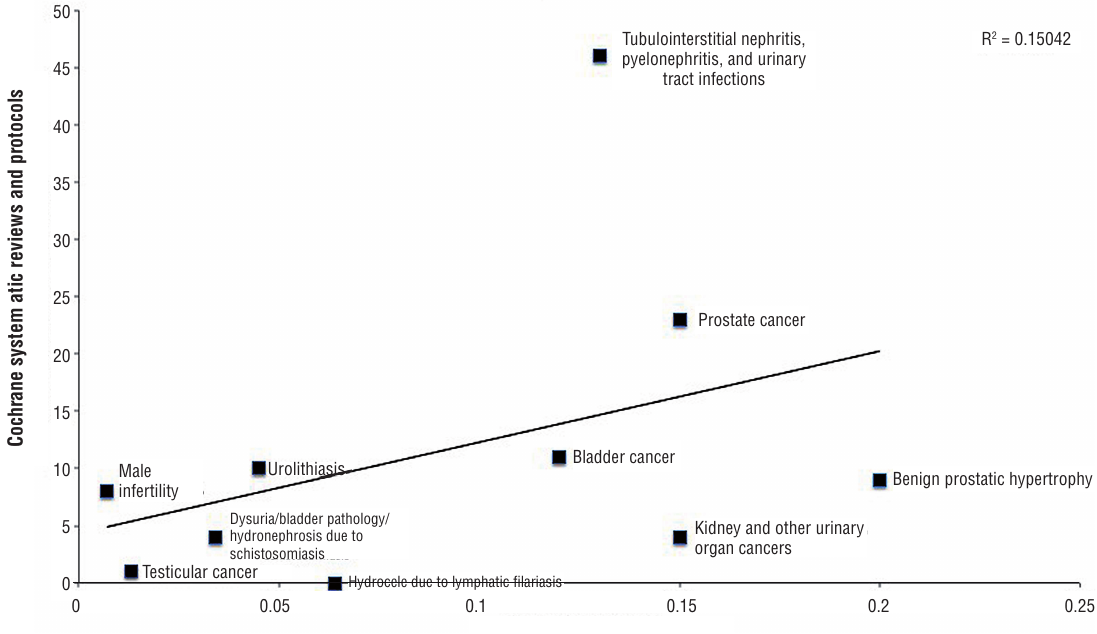
Figure 2 - Comparison of men’s health and urologic disease representation in the Cochrane Database of Systematic Reviews with percent of 2010 DALYs from 291 conditions studied by GBD